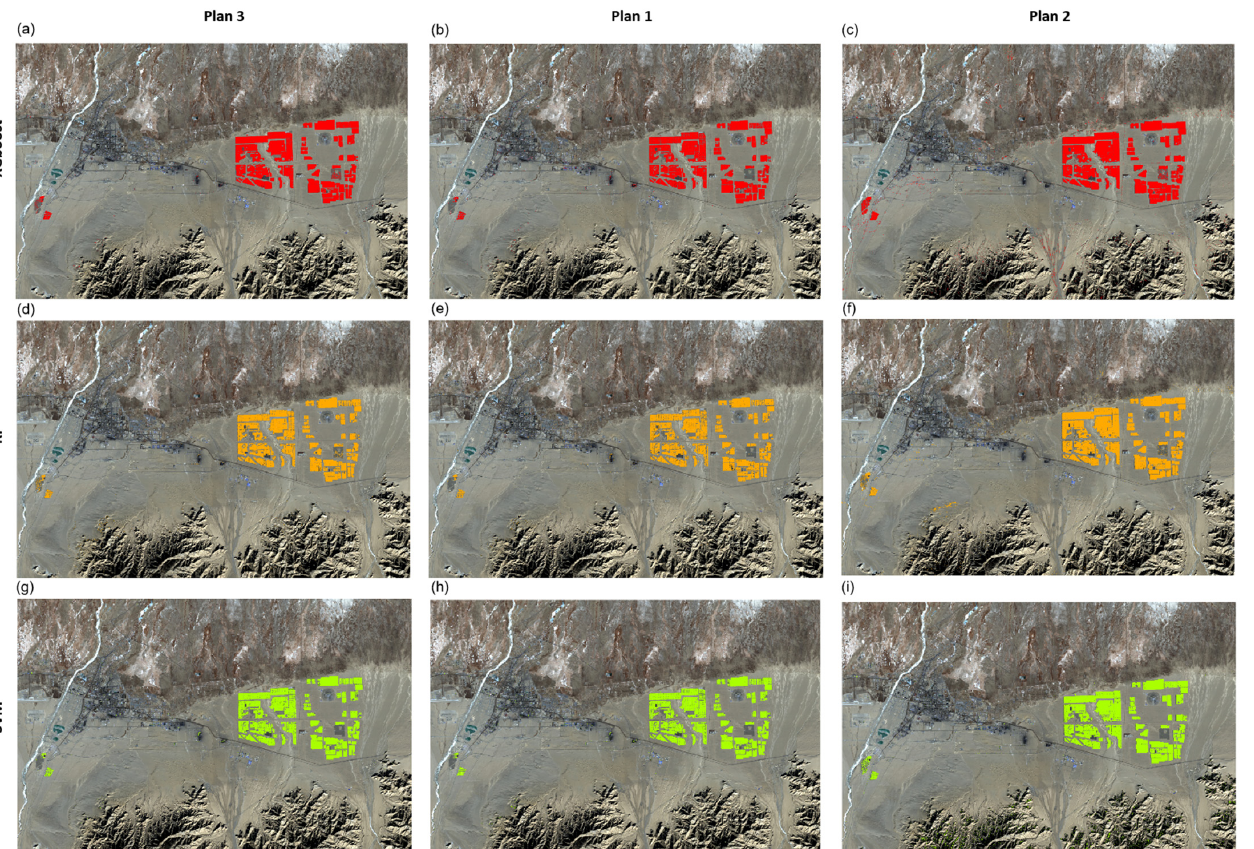
Figure 7. Images of extraction results based on different models showing the concentration of PV plants in contiguous areas in the east of Golmud City (the models (XGBoost, RF, and SVM) and plans (1, 2, and 3) are correspondingly shown as rows and columns). Red ( a – c ), yellow ( d – f ), and green ( g – i ) represent the PV extraction results for XGBoost, RF, and SVM, respectively, with Plan 3 yielding the best results for red (XGBoost).